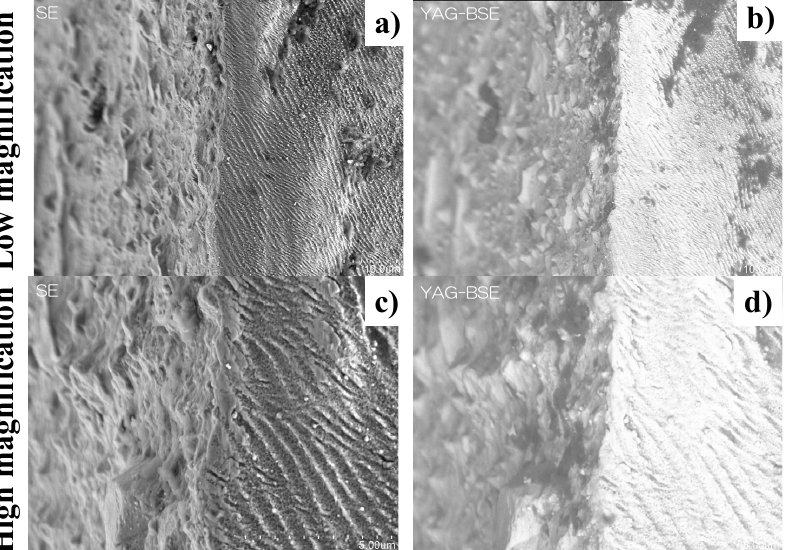
Figure 11. SEM and YAG-BSE images on the top and side surfaces of laser-trimmed SKD11 punch across its edge ( a , b ) in low magnification, and ( c , d ) in high magnification.